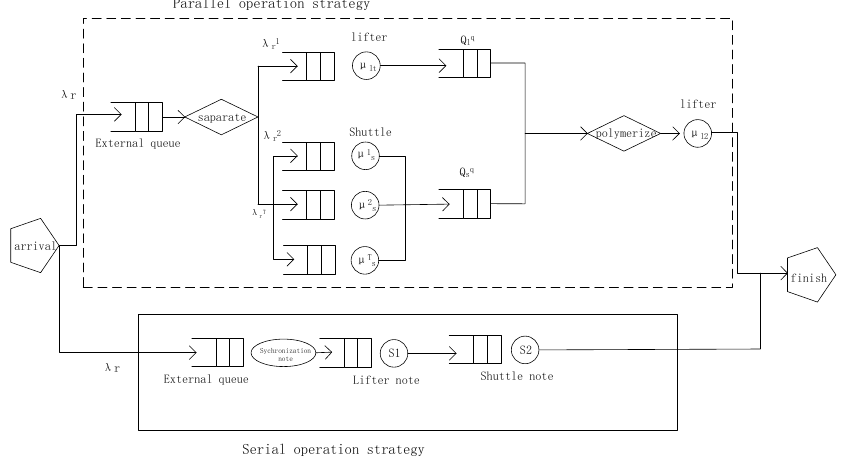
Figure 2. Four-way shuttle system outbound process queuing network model .